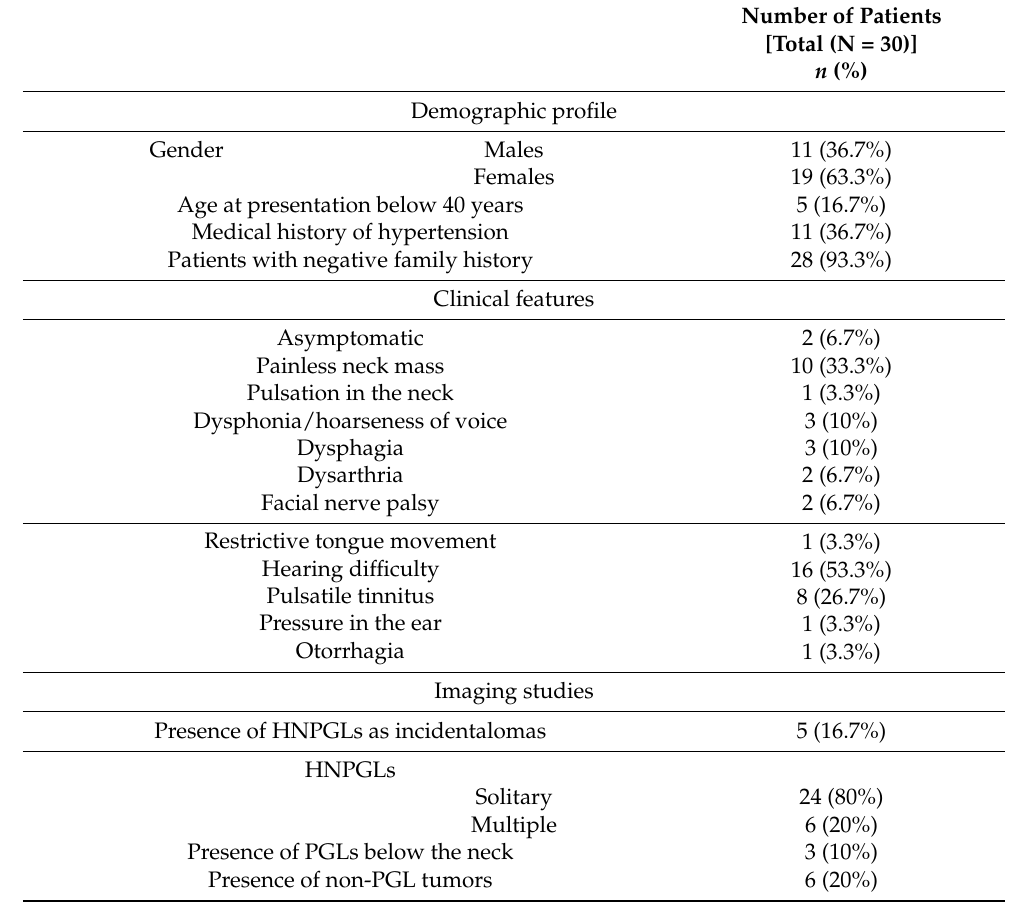
Table 2. Mode of presentation amongst HNPGLs